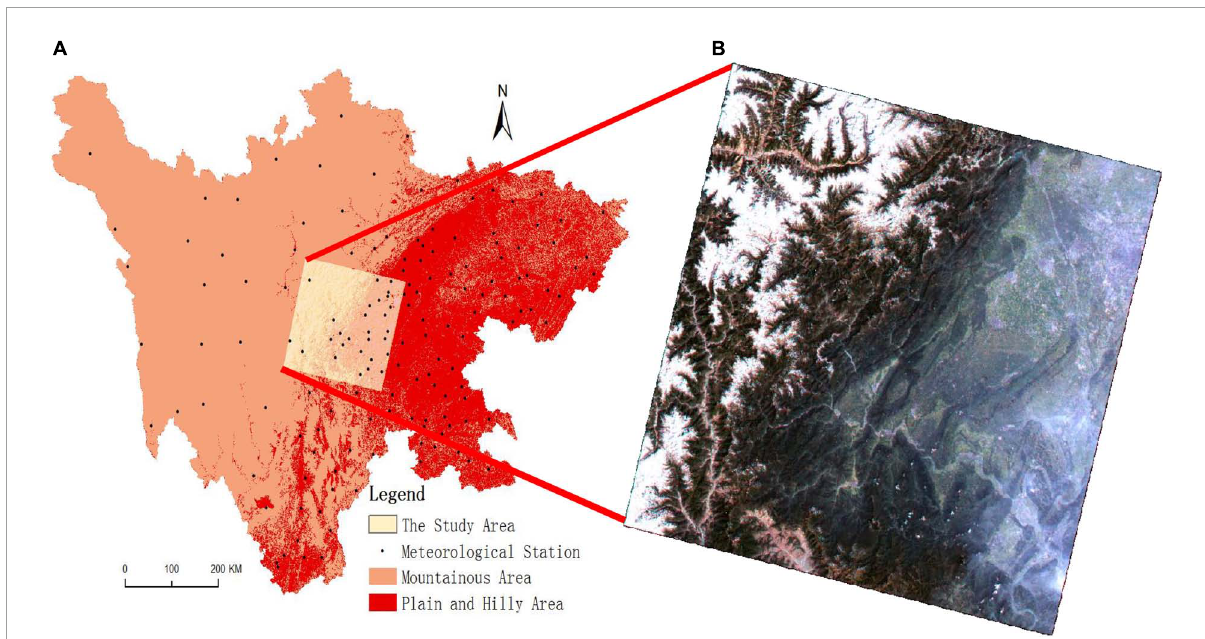
FIGURE1 Distribution of the study area and meteorological stations in the Sichuan mountainous areas (A) and Landsat 8 OLI data image in the study area in June 2016 (B) .